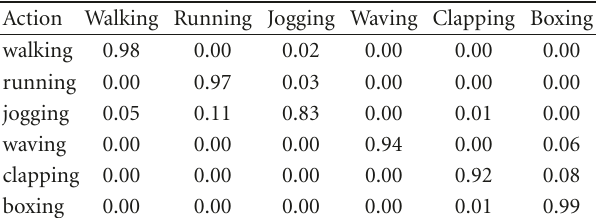
Table 1: Confusion matrix obtained on KTH dataset.